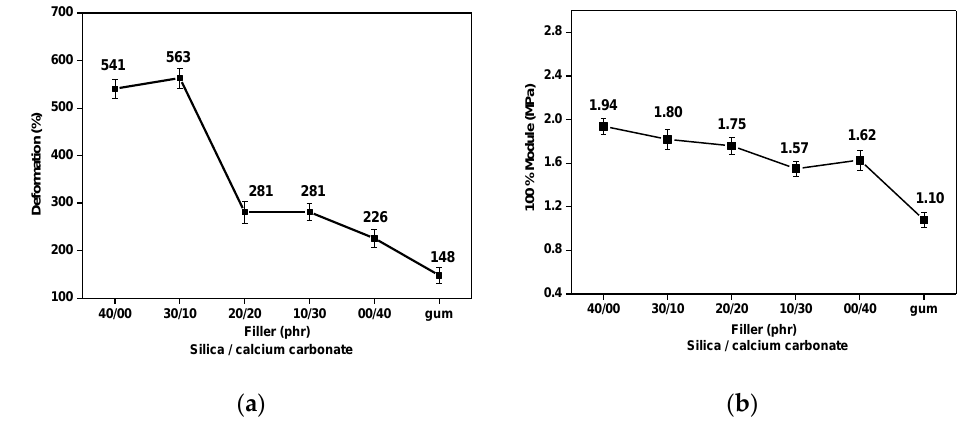
Figure 9. ( a ) Deformation at break ( b ) Modulus at 100% of hybrid composites.